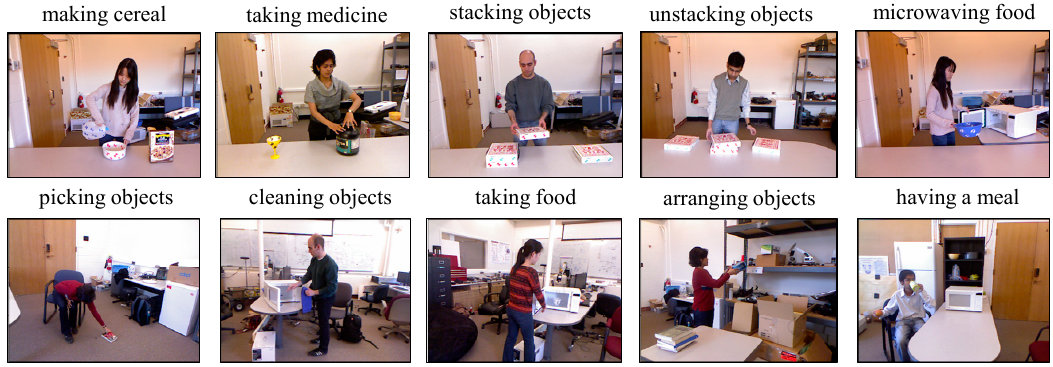
Figure 8. Sample RGB images from the CAD-120 dataset.